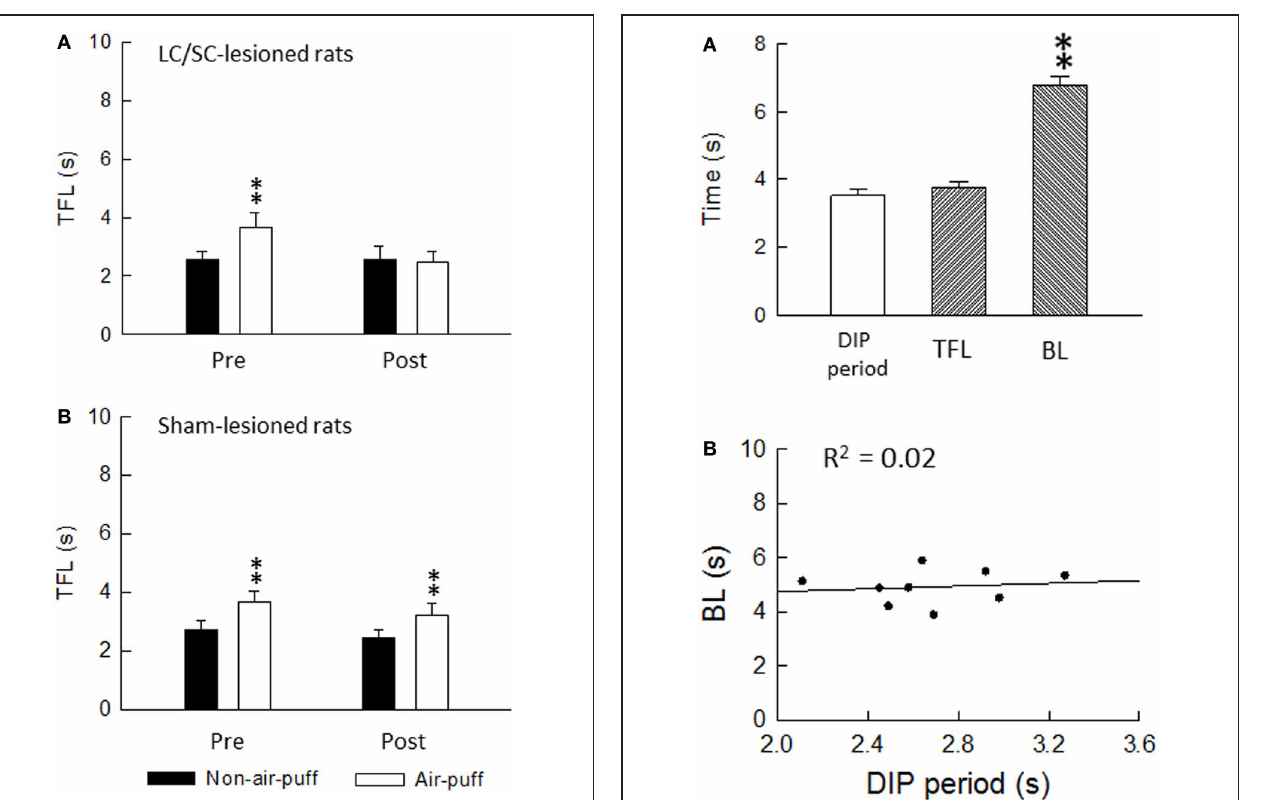
FIGURE 10 | (A) Air-puff stimulation-induced the DIP period ( n = 46), the tail flick latency ( n = 26) and the bite latency ( n = 40). ∗∗ P < 0 . 01, significantly different from DIP periods and tail flick latencies. Note that there was no significant difference between the DIP period and the tail flick latency, suggesting that the descending and ascending LC/SC systems simultaneously cease activity. (B) Regression analysis of the DIP period and the bite latency. Nine points were obtained from nine untreated rats. The regression line corresponds to y = 4 . 24 + 0 . 26 x . Note that the bite latency were nearly constant regardless of the change in the DIP period, suggesting that the bite latency are not influenced by the DIP period (Tsuruoka et al.,